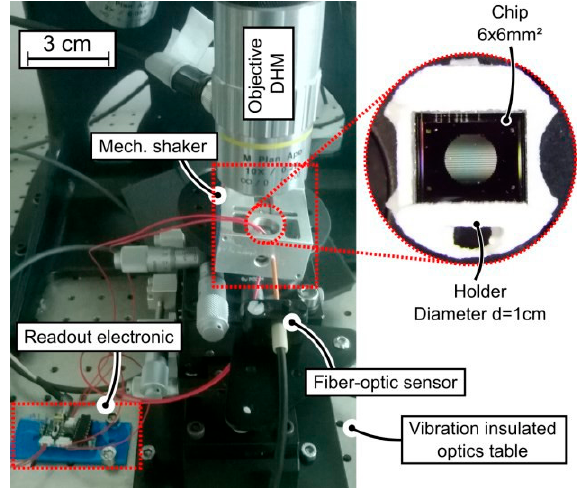
Figure 4. A piezo-electric shaker is used to introduce excitations in different spatial directions at a set of frequencies. The deflections of the mass and the applied excitation amplitudes are evaluated with a digital holographic microscope and a fiber-optic sensor, respectively. The output from the readout circuit is recorded with a lock-in